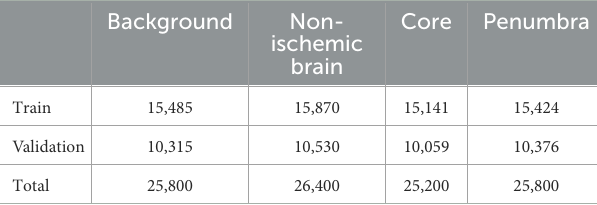
TABLE 1 Class representations across the training and validation